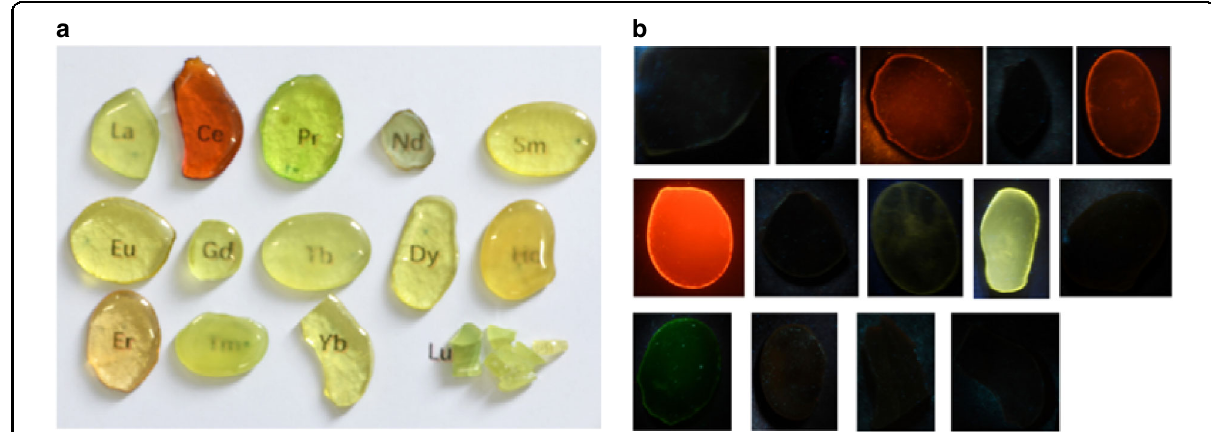
Fig. 1 Photoluminescence properties of rare earth ions doped glass. a Photos of rare earth ions doped tungsten – phosphate glass with the molar compositions of